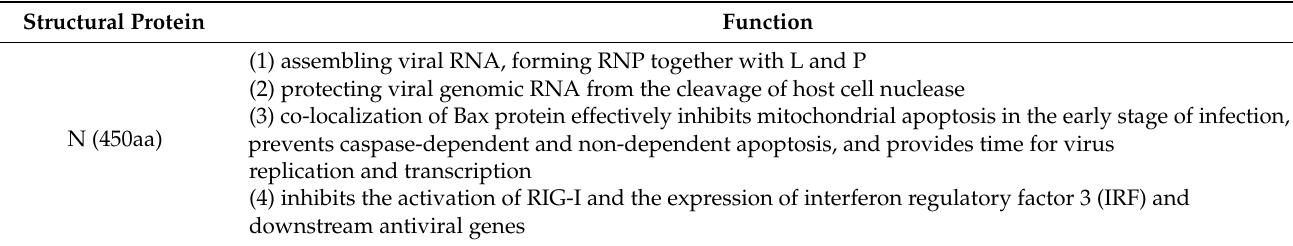
Table 1. Virus–Host Interactions in Rabies Virus